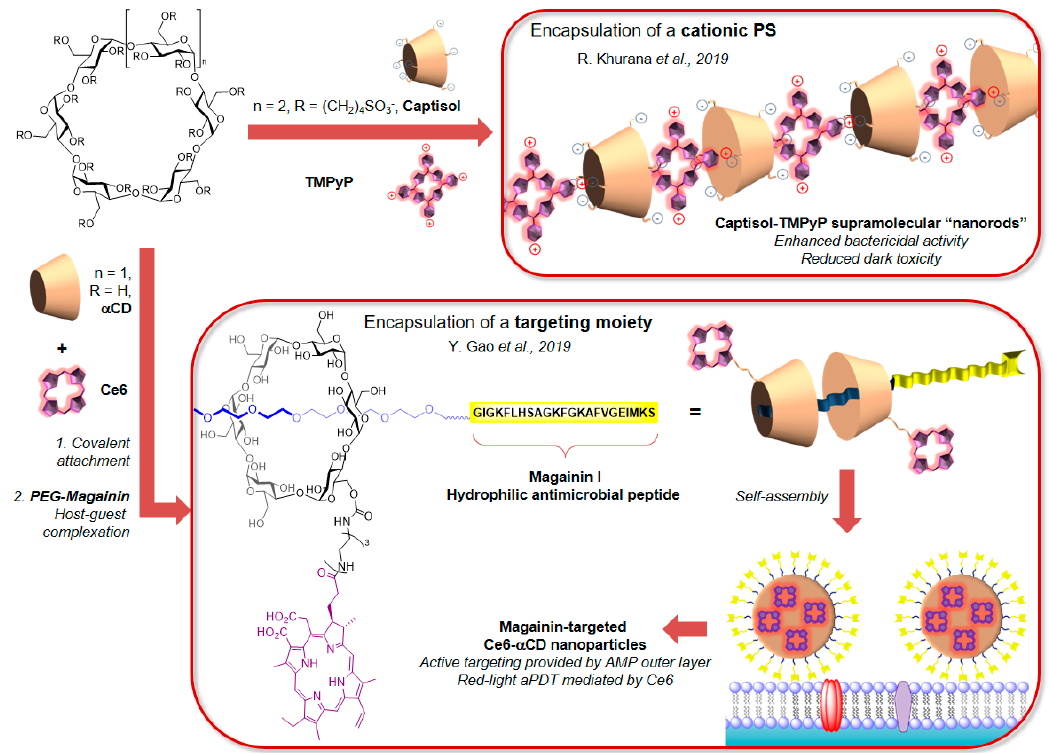
Figure 10. Examples of cyclodextrin derivatives used for the preparation of PS-containing NPs, either by encapsulation of the PS units [136], or by encapsulation of an AMP acting as a bacterial-targeting moiety